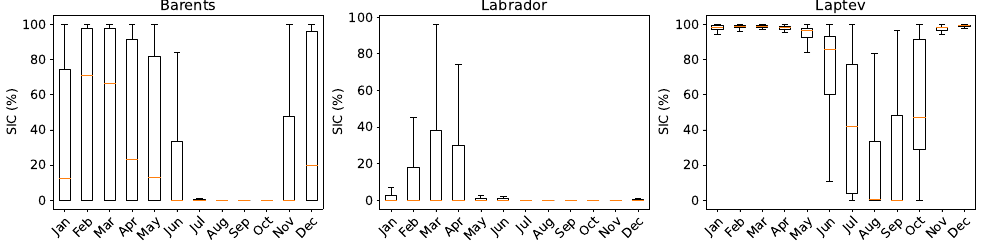
Figure 1. Box and whisker plots of SIC data distribution in JAXA for different months of 2021, aggregated for all the cells in each region. The box extends from the 25th percentile to the 75th percentile; whiskers extend the box by 1.5 × of its length. The orange line is the median (50th percentile); outliers are omitted in order not to clutter the